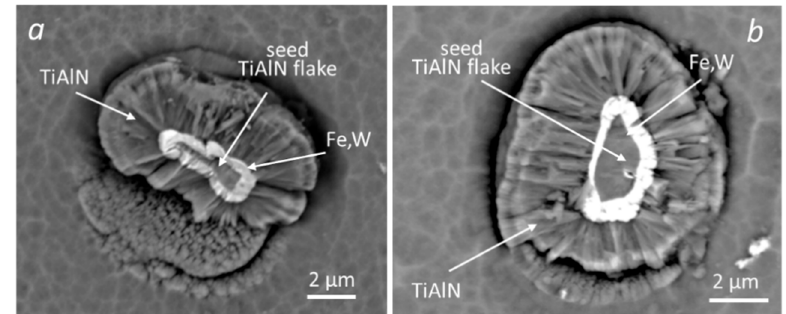
Figure 22. SEM images of the broken nodular defects in the sputter-deposited TiAlN hard coating. Seed particles are clearly visible at the fracture. The origin of these seed particles is the target of magnetron sources.